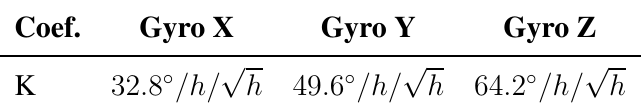
Table 4. Rate random walk noise coefficients for IMT30 gyros. Mean value of five tests. Coef.